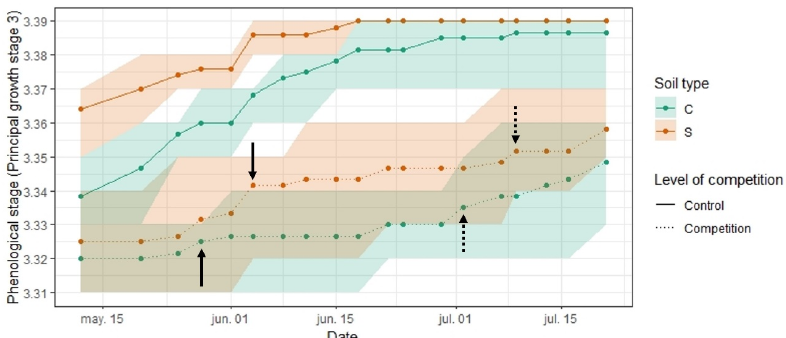
Figure 1. Phenology of LANZA ® in each treatment from 12 May 2021 to 21 July 2021 according to the BBCH system. Shaded area indicates range of the phenological stage (from plant with the lowest phenological stage to the plant with the highest). Solid arrows indicate the date at which all L. mul- tiflorum plants reached stage 5 (inflorescence emergence) in each soil type. Dotted arrows indicate the date at which all L. multiflorum plants reached stage 8 (ripening or maturity of fruit and seed) in each soil type. C: clay soil; S: loamy sand soil. This is in agreement with the results of the analysis of the phytovolume of LANZA ® . Significant differences were found by level of competition (df = 1; F = 44.04; p < 0.001) and soil type (df = 1; F = 7.71; p < 0.05) for the phytovolume measured at day 65. Control plants showed significantly higher phytovolume than their counterparts grown under competi- tion (averaged values by level of competition: 9160 ± 1003 SE cm 3 in control and 2396 ± 607 SE cm 3 in competition). Plants grown in S soil also had higher phytovolume than plants grown in C soil (averaged values by soil type: 7193 ± 1456 SE cm 3 in S and 4362 ± 984 SE cm 3 in C). At harvesting time on day 135, the differences by level of competition were also significant (df = 1; F = 86.04; p < 0.001), but no significant differences were found by soil type (df = 1; F = 2.68; p = 0.117). Figure 2 shows an example of plants at the two dates of measurement in each treatment.